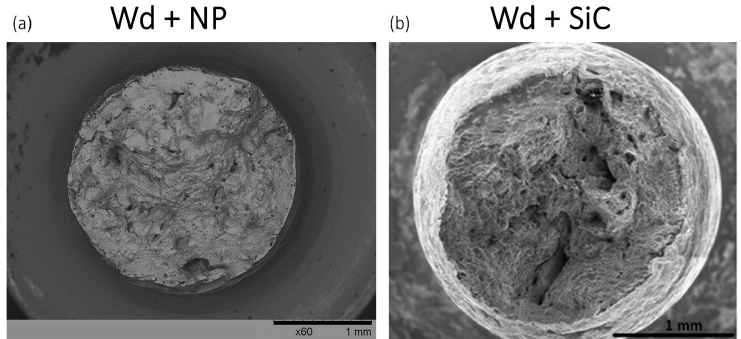
Figure 10. The fracture surface of the Ti-6Al-4V alloy creep tested at 600 °C and 250 MPa, (a) plasma nitrided (Wd + NP) and (b) SiC coated (Wd + SiC).